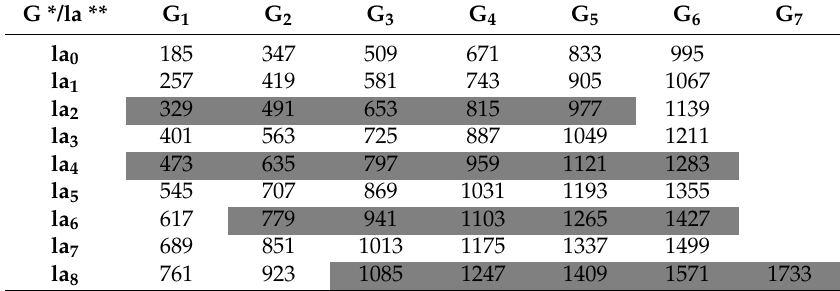
Table 1. The m / z values of the fragments issued from the semiacetalic bond cleavages; the values corresponding to the most intensive peaks are highlighted and the values of the peaks which were not found or were of low intensity are not highlighted.